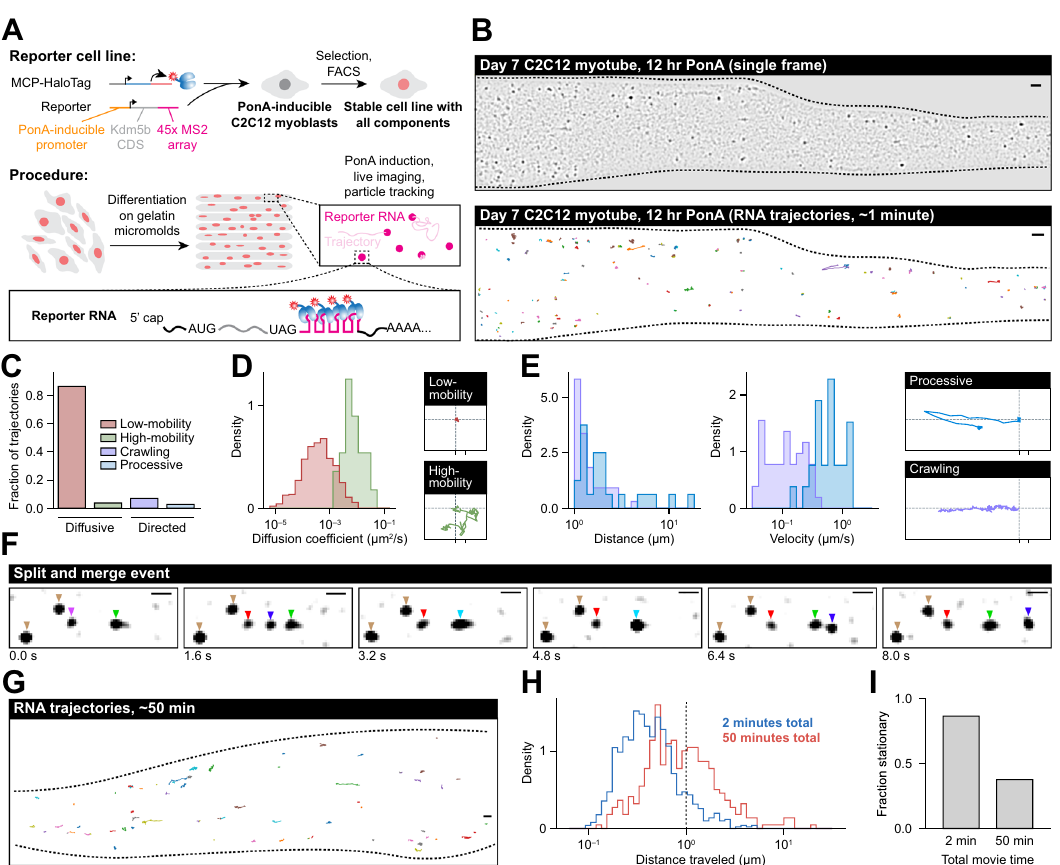
Fig. 8 RNAs exhibit restricted diffusion and directed transport in myotubes. A Schematic describing MS2 live-cell RNA imaging strategy. B Example image of a myotube expressing MS2-labeled RNA (top) and RNA trajectories (bottom) from a 53-s imaging time course. Scale bars: 2 µ m. C Percentage of RNA trajectories in each motion category. D Diffusion coef fi cients for low-mobility (red) and high-mobility (green) diffusive tracks and example tracks from both groups. X-axis ticks for scale: 0.5 µ m. E Distance and velocity for processive (blue) and crawling trajectories (purple) along with example tracks from both groups. X-axis ticks for scale: 0.5 µ m. F Series of images showing RNA particle splitting and merging events. Colored triangles denote particle identities. Scale bars: 1 µ m. G Example RNA tracks from a myotube expressing MS2-labeled RNA during a 50-min imaging time course. Scale bars: 2 µ m. H Maximum distance traveled for each track from the 50-min (red) and 2-min (blue) imaging time courses. Tracks below dotted line (1 µ m) are categorized as stationary. I Fraction of stationary tracks in 50-min and 2-min time